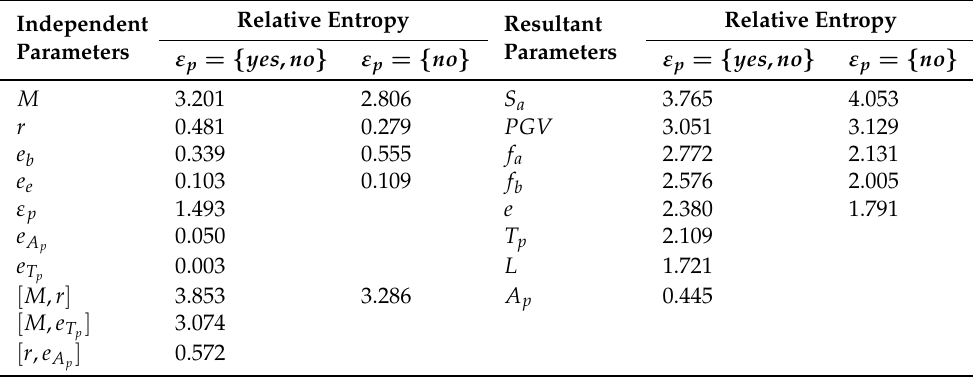
Table 2. Probabilistic sensitivity analysis results for ground motion with probabilistic pulse and no pulse for chevron-braced